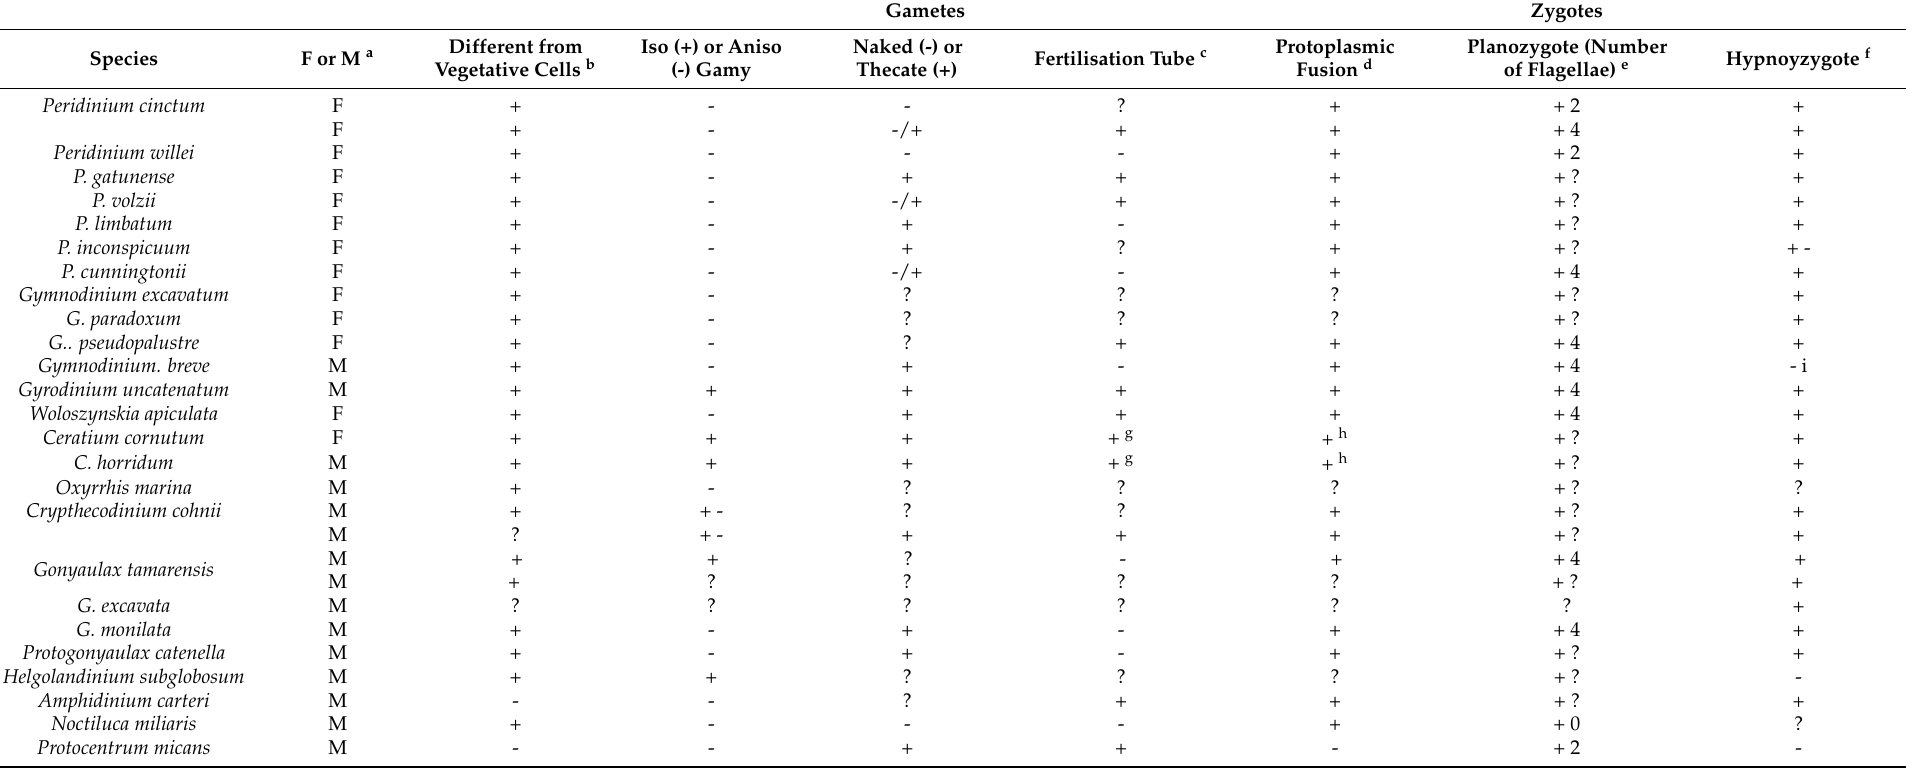
Table 1. Comparison of features of sexual reproduction in 25 dinoflagellate species: Full references of all the authors cited in this table can be found in Bhaud et al.